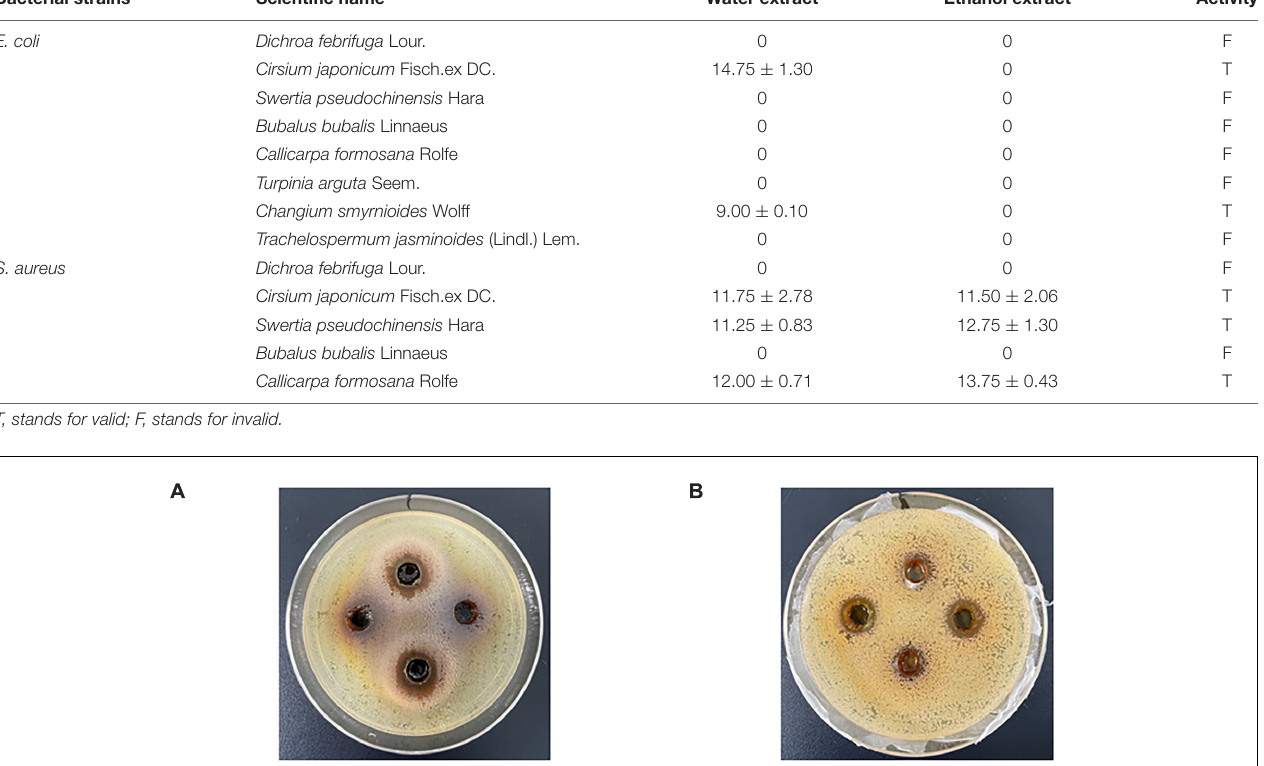
(Swertiae Herba, Changii Radix) and the predicted six TCMs, including Dichroae Radix and Cirsii Japonici Herba Carbonisata, were in accordance with the experimental results. Overall the accuracy of prediction was 75%. In the forecast of the anti- S. aureus activity of TCMs, the results of Dichroae Radix and Bubali Cornu were inconsistent with the experiment; however, three TCMs (Cirsii Japonici Herba Carbonisata, Swertiae Herba, Callicarpae Formosanae Folium) were in good